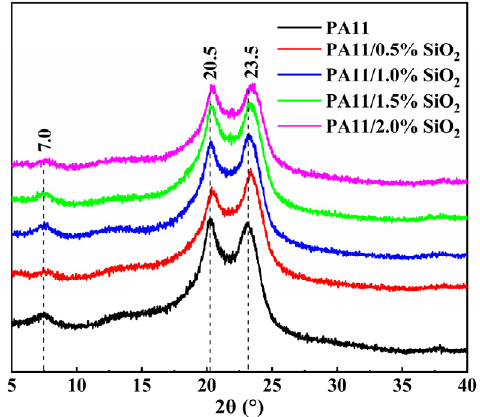
Figure 6. XRD spectra of PA ‐ 11 and PA11/SiO 2 composites.